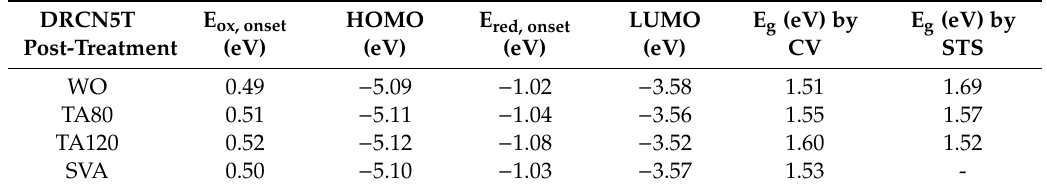
Table 1. Energy levels and band gaps of DRCN5T small molecule at di ff erent post-treatments measured by cyclic voltammetry (CV, thickness = c.a. 120 nm onto ITO) and by scanning tunneling spectroscopy (STS, thickness = c.a. 700 pm onto